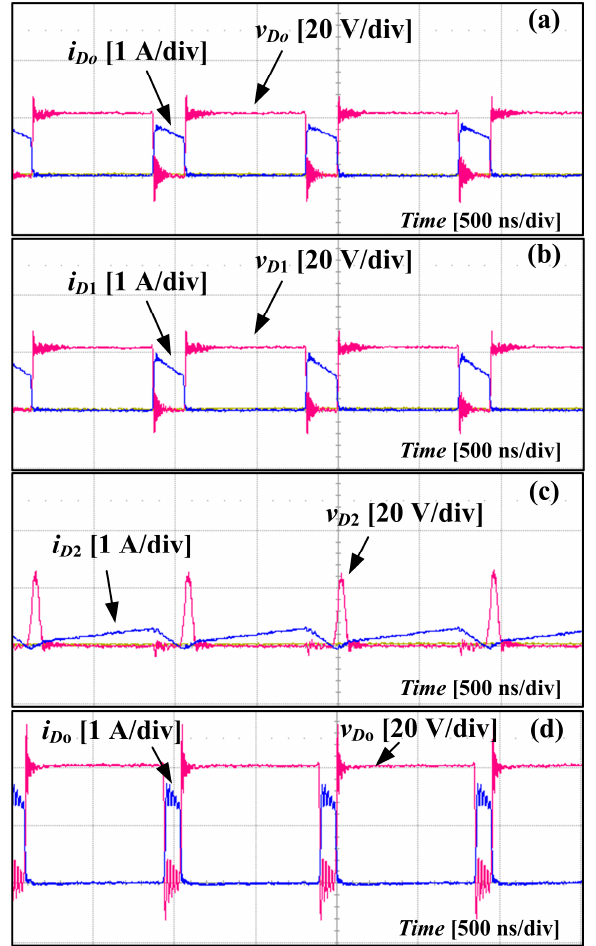
Figure 10. Diode waveforms of the proposed converter. ( a ) D o , ( b ) D 1 , ( c ) D 2 , and diode waveform of the conventional boost converter. ( d ) D o measured at V IN = 5 V, V O = 40 V, I O = 150 mA and f S = 1 MHz.